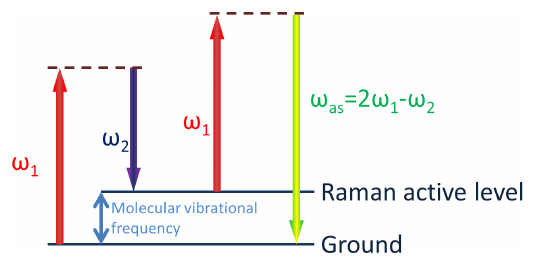
Fig. 1. Energy diagram of CARS